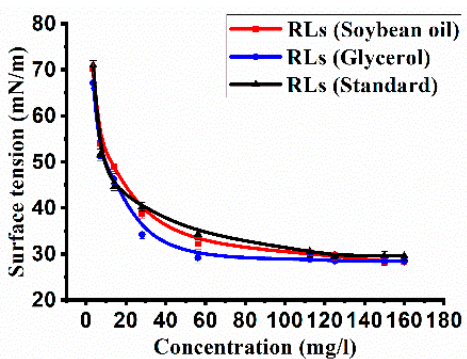
Figure 3. The critical micellar concentration (CMC) determination for rhamnolipids. The CMC was determined by measuring the changes of surface tension with different concentrations of rhamnolipids. The error bars represent standard deviations from three independent experiments ( n = 3).